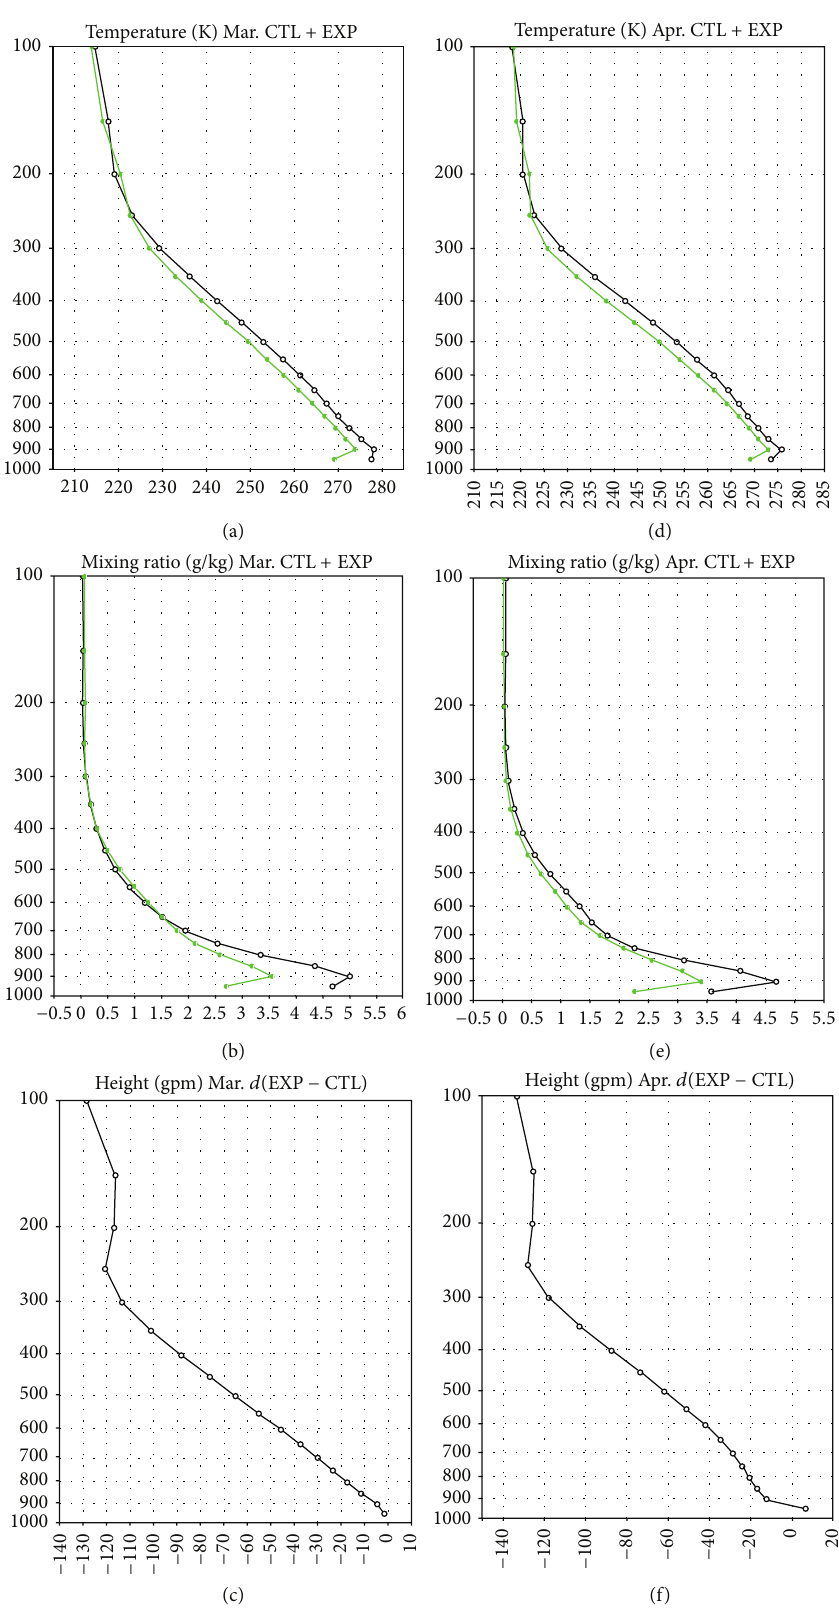
Figure 6: Vertical profile of temperature ((a), (d)) and mixing ratio ((b), (e)) of CTL (open circle) and EXP1 (green line) and the geopotential height differences ((c), (f)) for March (left panel) and April (right panel) over the entire model